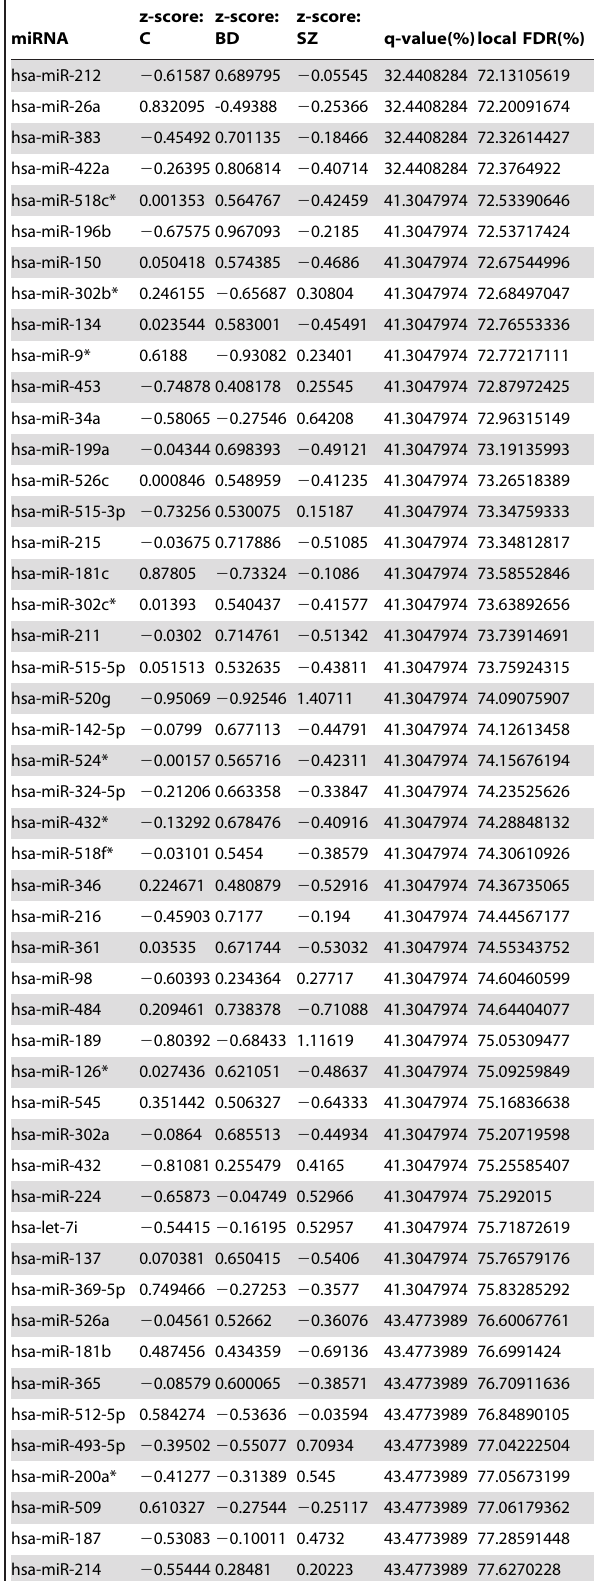
according to the same manufacturer’s protocol. Briefly, cDNA was diluted to a final concentration of 0.1 ng/ul, added to a primer set